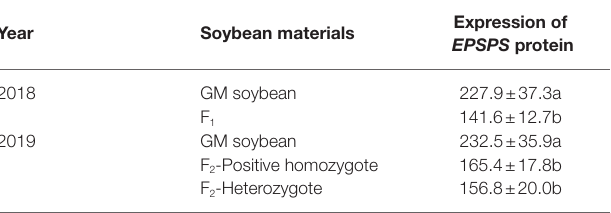
TABLE 3 | Expression of EPSPS protein in apical leaves of transgenic soybean and hybrid progeny at 3–4 leaf stage ( μ